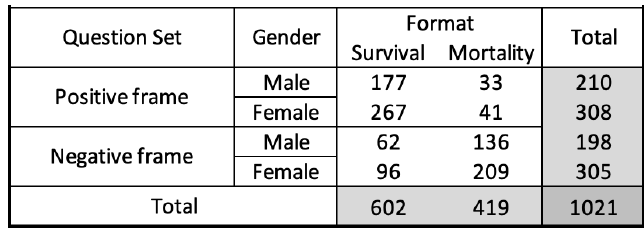
Figure 3. Respondent totals by gender.